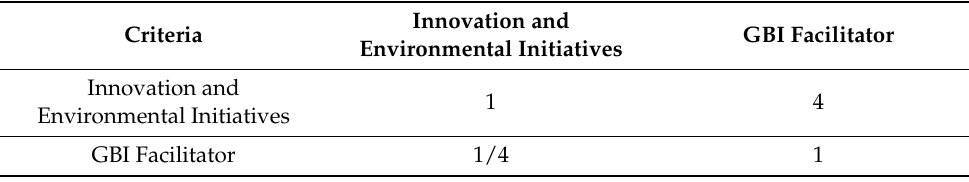
Table 3. Paired comparison matrix for the innovation (IN) attribute.